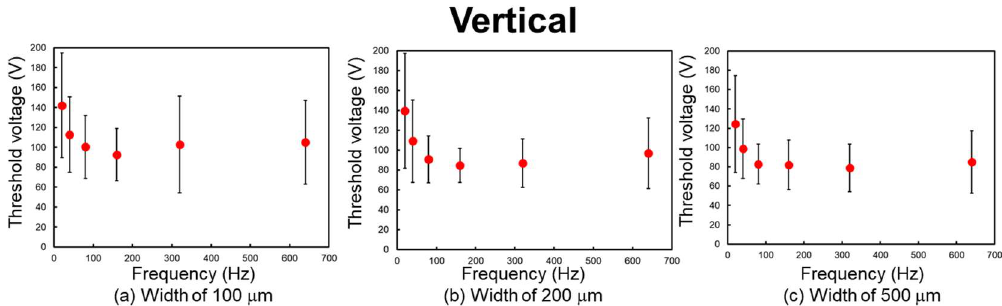
Figure 8. Relationship between frequency and threshold voltage. The finger was positioned vertically to the length of the electrodes, as shown in Figure 5d. ( a ) Width of 100 µ m. ( b ) Width of 200 µ m. ( c ) Width of 500 µ m. Table 1. Summary of the experimental results.